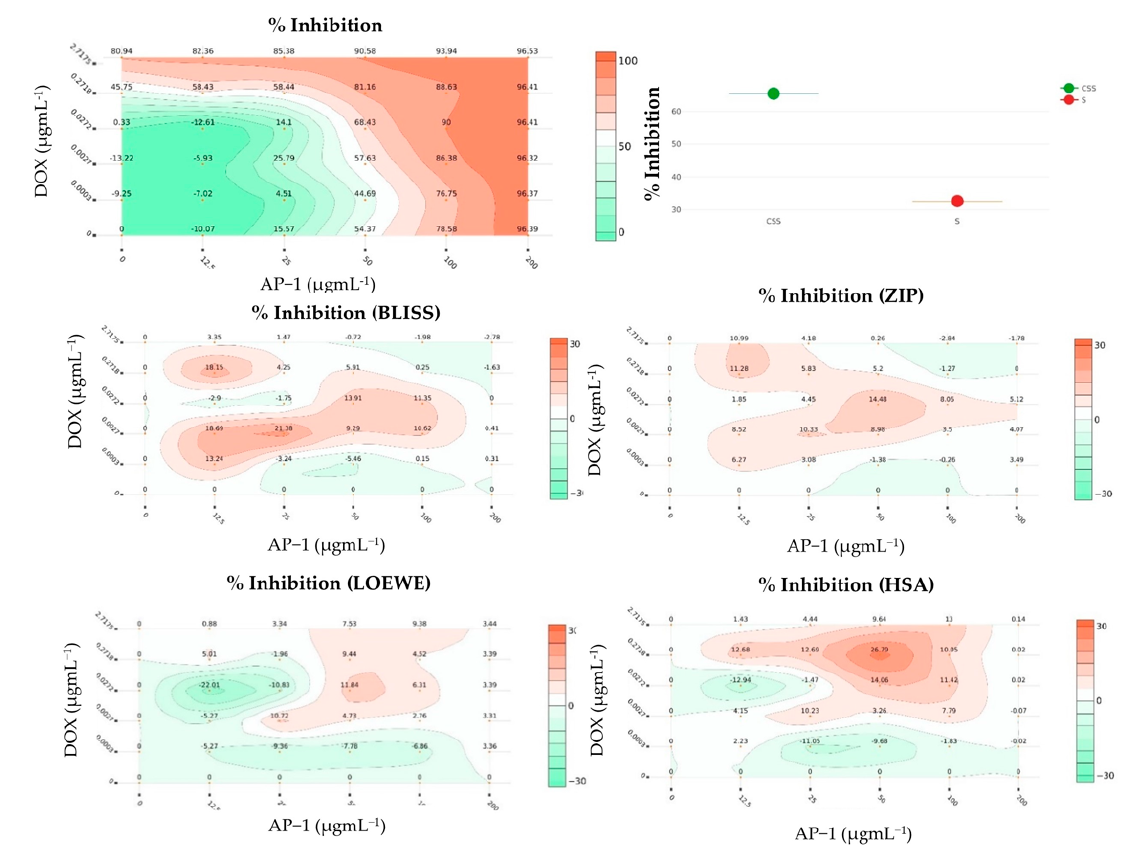
Figure 3. Synergy and sensitivity quantitation of AP-1 in combination with DOX against the MCF7 cells in a checkerboard